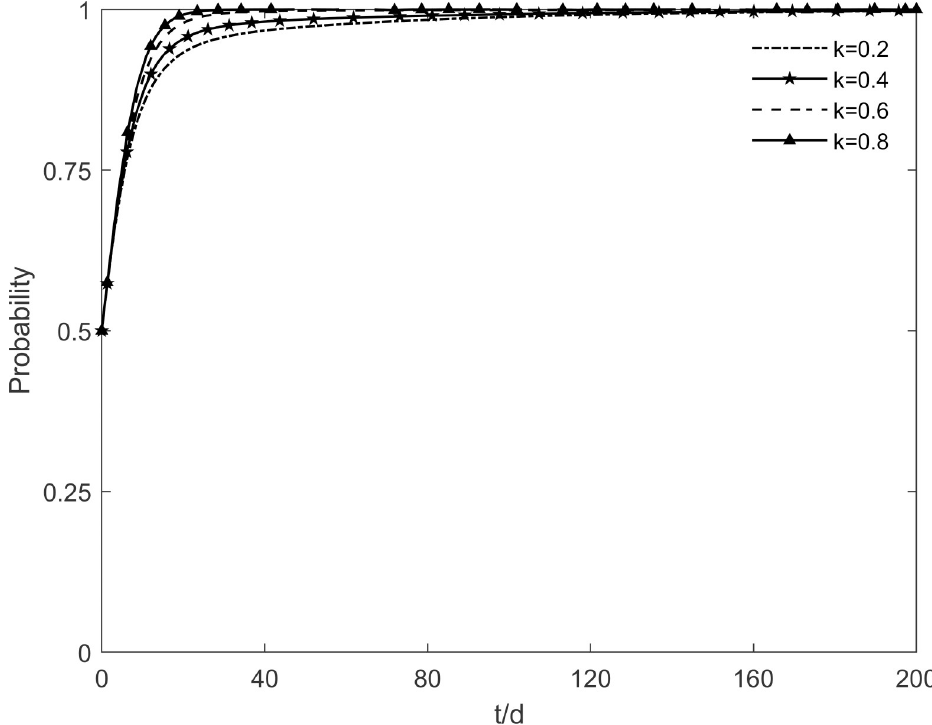
Fig 18. The impact of k on the government’s strategic